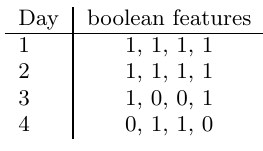
Table 4: Boolean features ordered as: { home, work } , { home, restaurant } , { home → restaurant } , { home → work → work